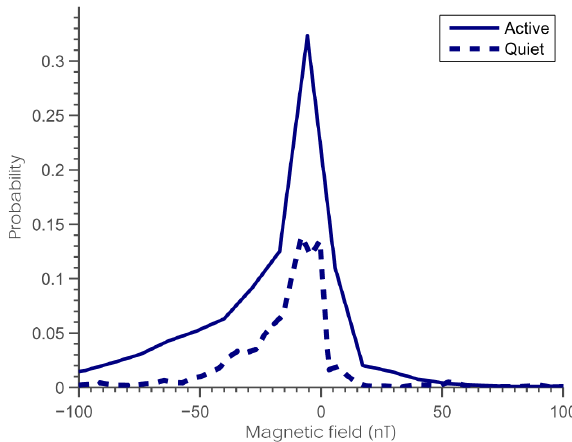
Fig. 2. Distribution functions for the active and quiet events ana- lyzed for the X component magnetic field at the MSR magnetome- ter station. The dashed line represents the averaged distributions for the quiet events and the solid line represents the averaged distribu- tions for the active